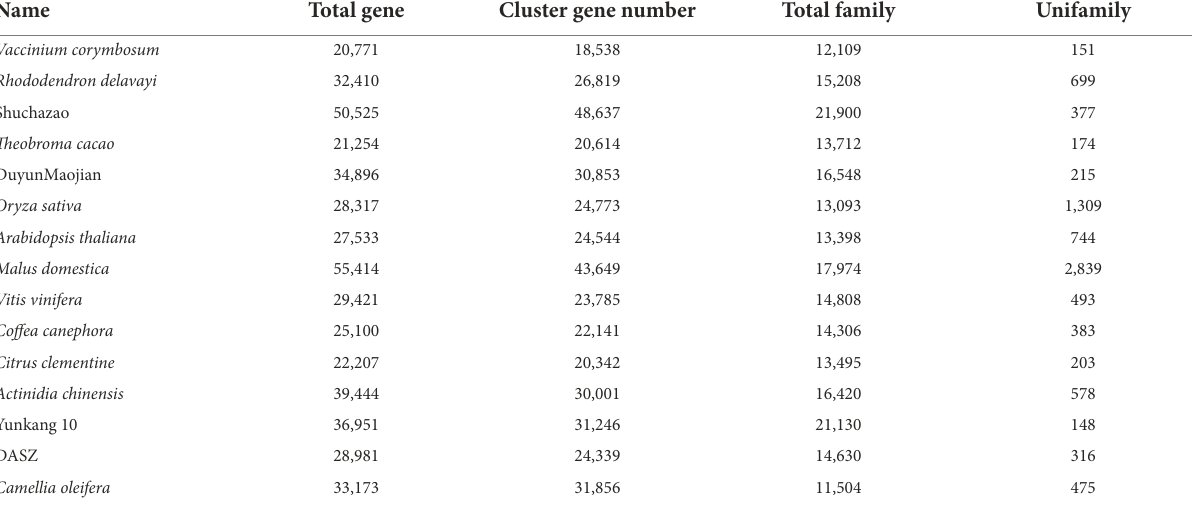
TABLE 2 Classification of gene